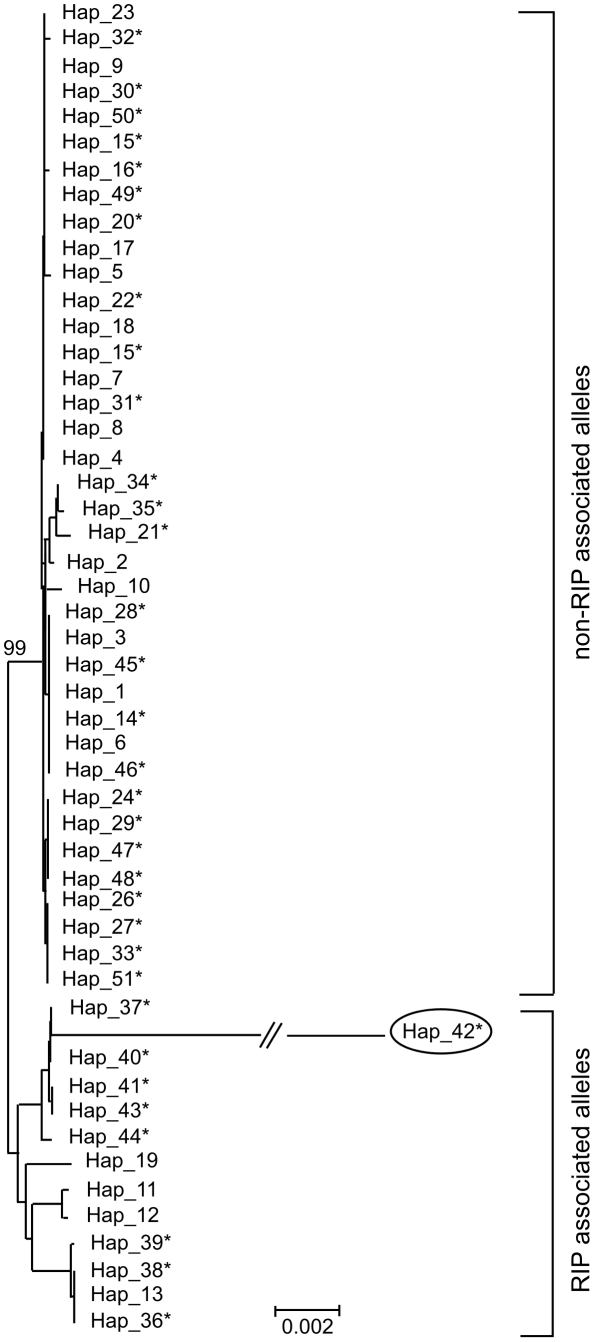
Genetic diversity and phylogenetic relationships between haplotypes of Leptosphaeria maculans.
Un-rooted strict consensus of 1000 ML trees (-ln L  =  16381.75) constructed from the concatenated DNA sequences of the seven genes and four non-coding, non-repetitive regions of the AvrLm1-LmCys2 genomic region. All CpA to TpA and TpG to TpA nucleotide changes were removed from the data set prior to analysis. Haplotypes (see Table S6) associated with RIP alleles cluster in a distinct clade with high bootstrap support (99%), suggesting a single origin. In contrast, haplotypes related to deletion alleles (*) are associated with multiple clades suggesting multiple origins. Note that RIP associated alleles have much longer branches (i.e. larger genetic distance) due to an accelerated evolution compared to non-RIP alleles (see Table 6). Haplotype 42 (circled) has RIP alleles at five of the loci examined (NC3, AvrLm6, LmCys1, NC4 and LmTrans), resulting in an exceptionally long branch.